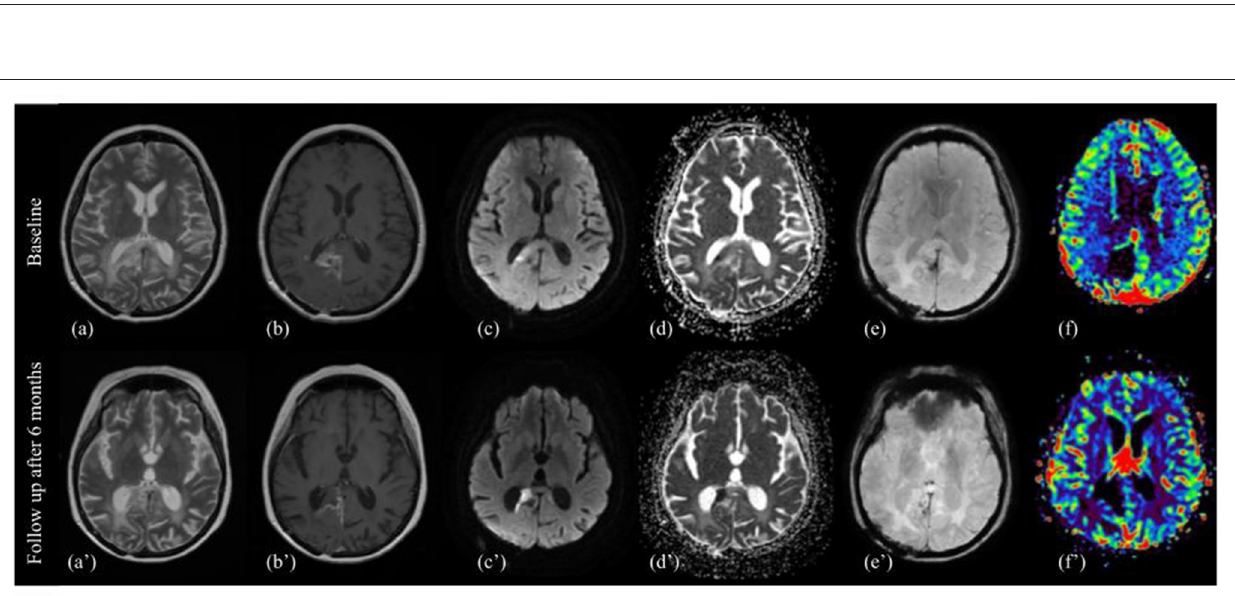
Frontiers in Radiology |